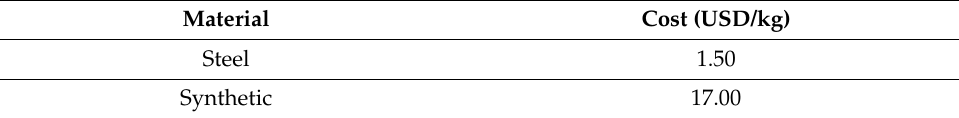
Table 2. Mooring System Material Costs.